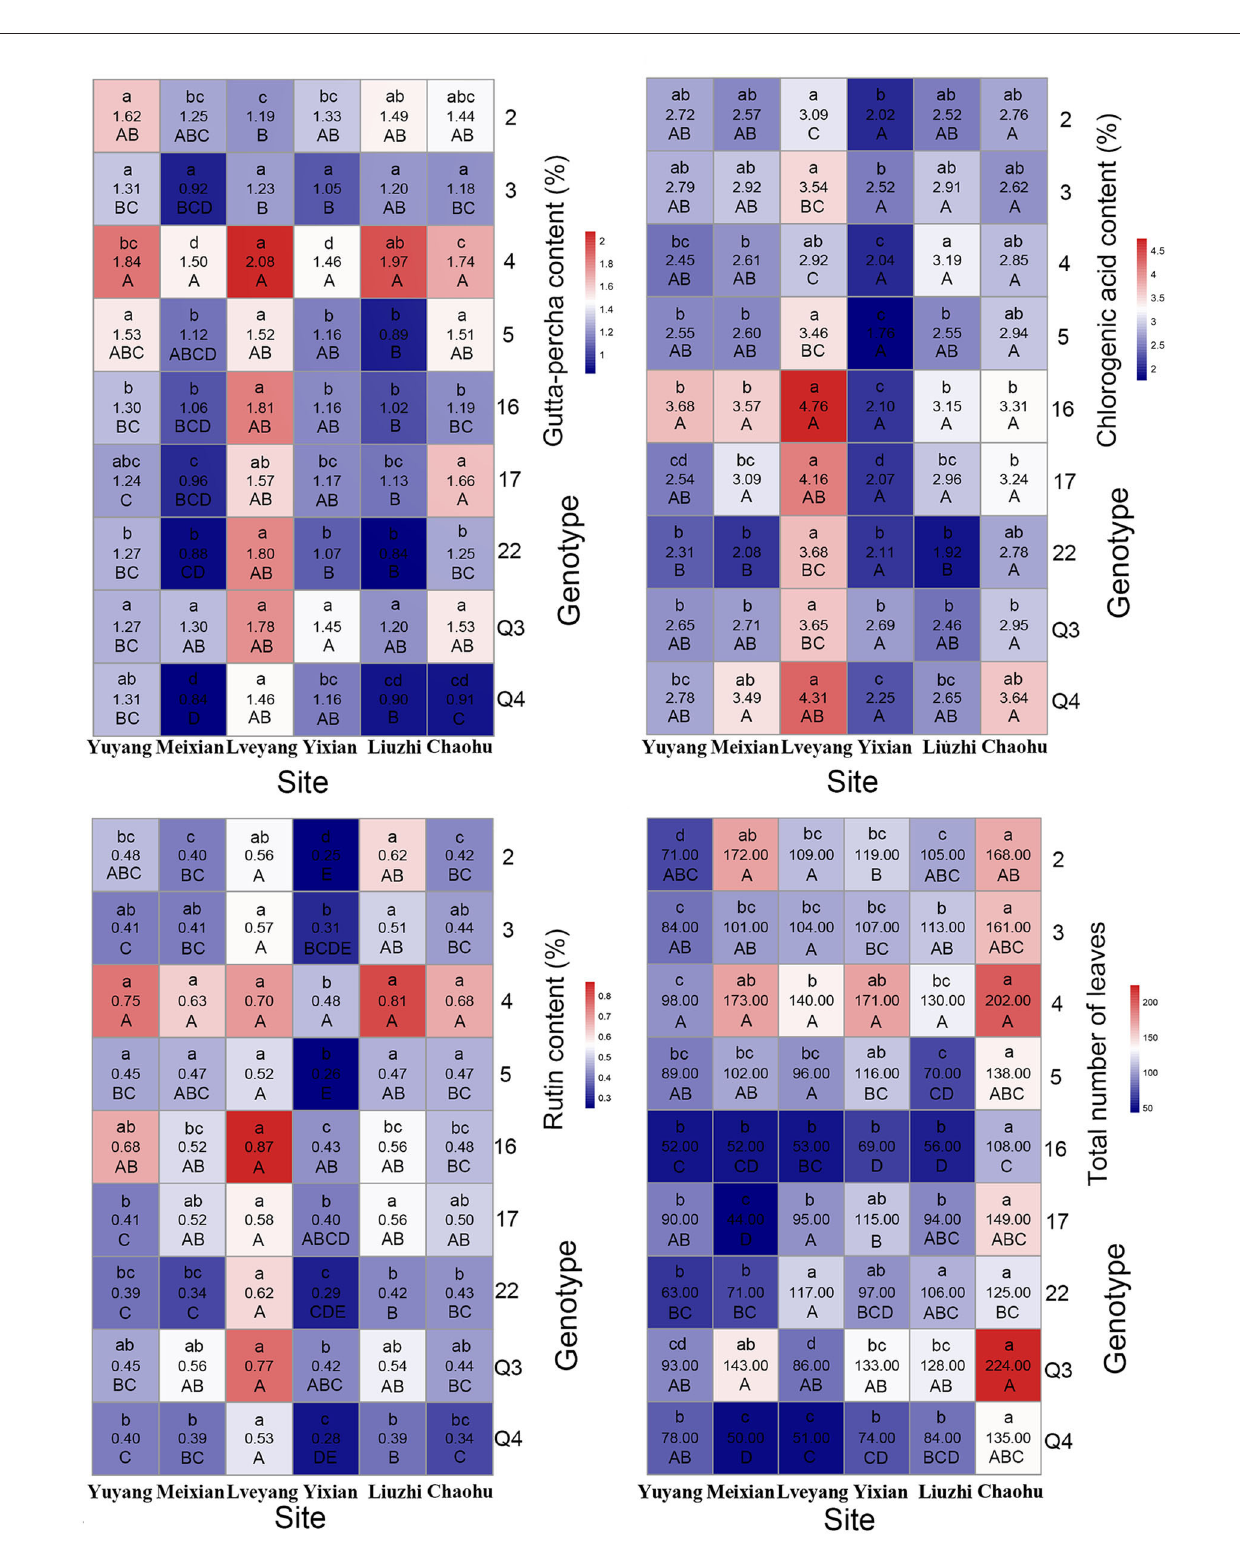
FIGURE 3 | Mean heat map of economic traits and leaf yield. For each grid, the number in the middle indicates the trait mean of a clone at a site. The capital letter below the number indicates the multiple comparison results among clones for a certain site. The lowercase letter above the number indicates the multiple comparison results among the sites for a certain